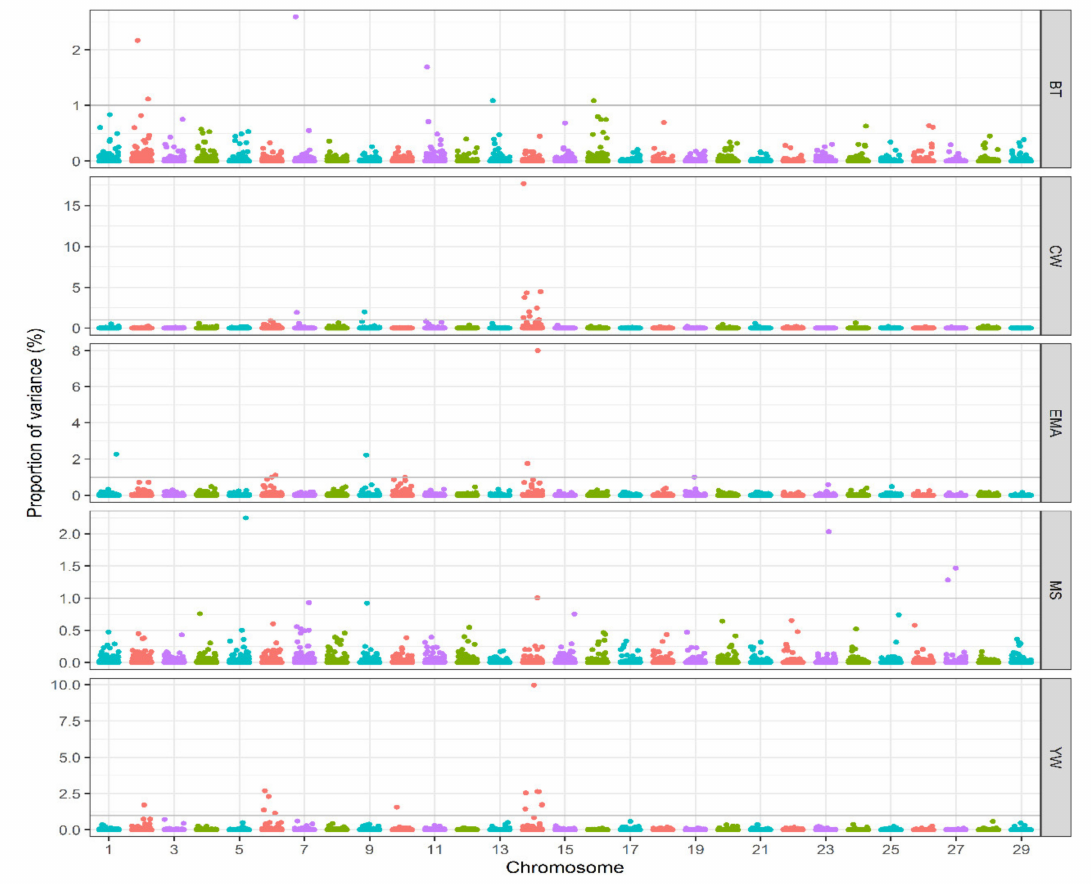
Figure 1. Manhattan plots of the percentage of additive genetic variance explained by windows of 20 adjacent SNPs for all studied traits using R software (version 4.0.2). BT, Backfat Thickness; CW, Carcass Weight; EMA, Eye Muscle Area; MS, Marbling Score; YW, Yearling